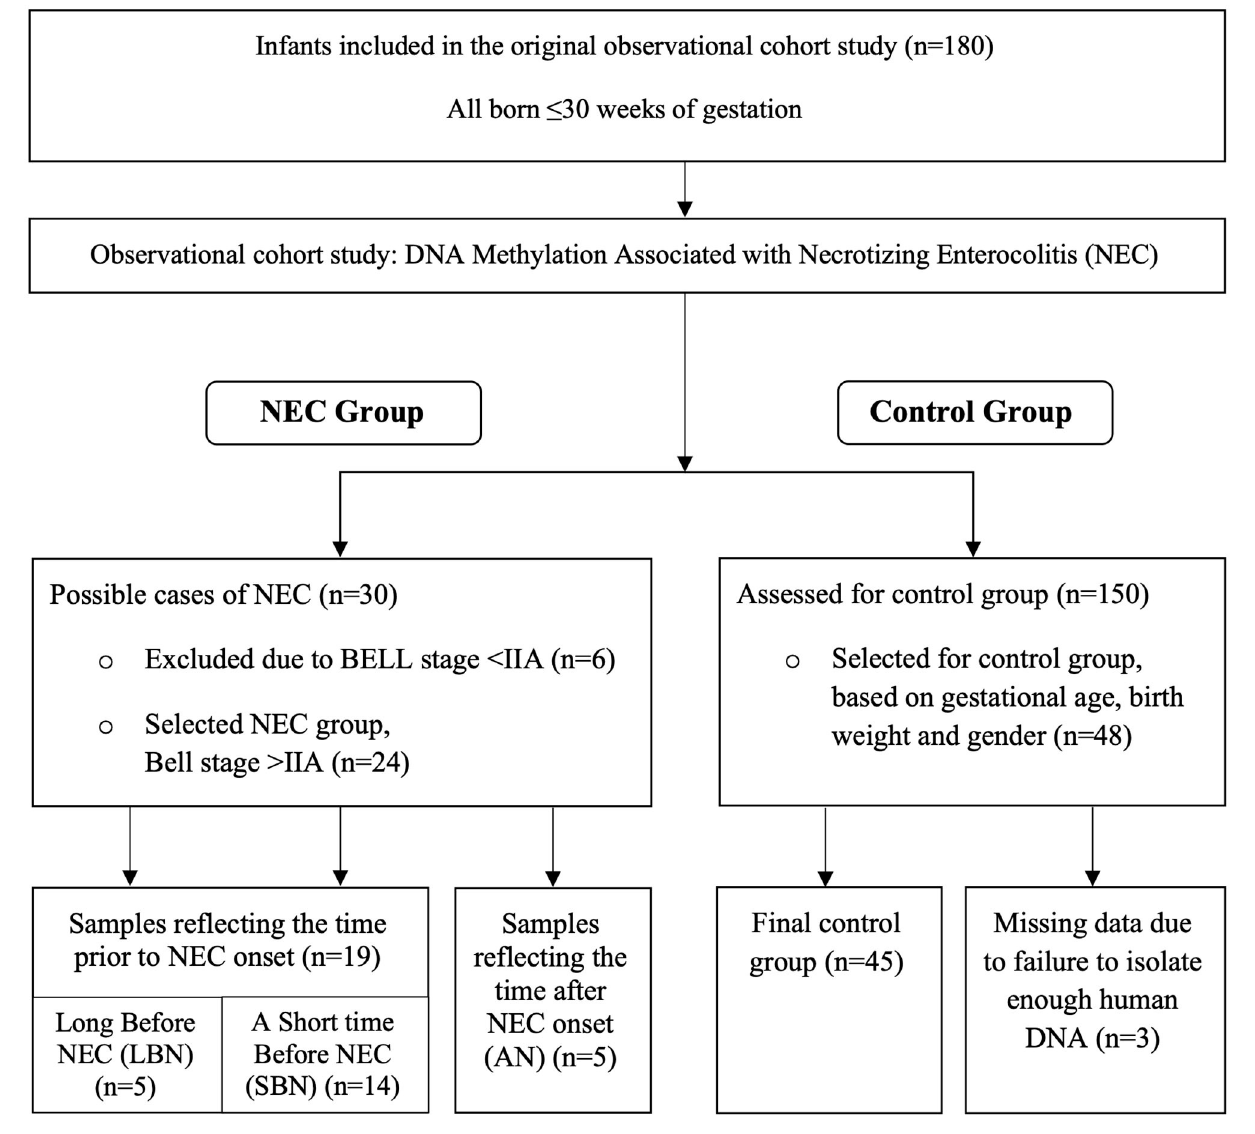
FIGURE 1 | Flow diagram presenting the selection of Necrotizing Enterocolitis (NEC) infants and